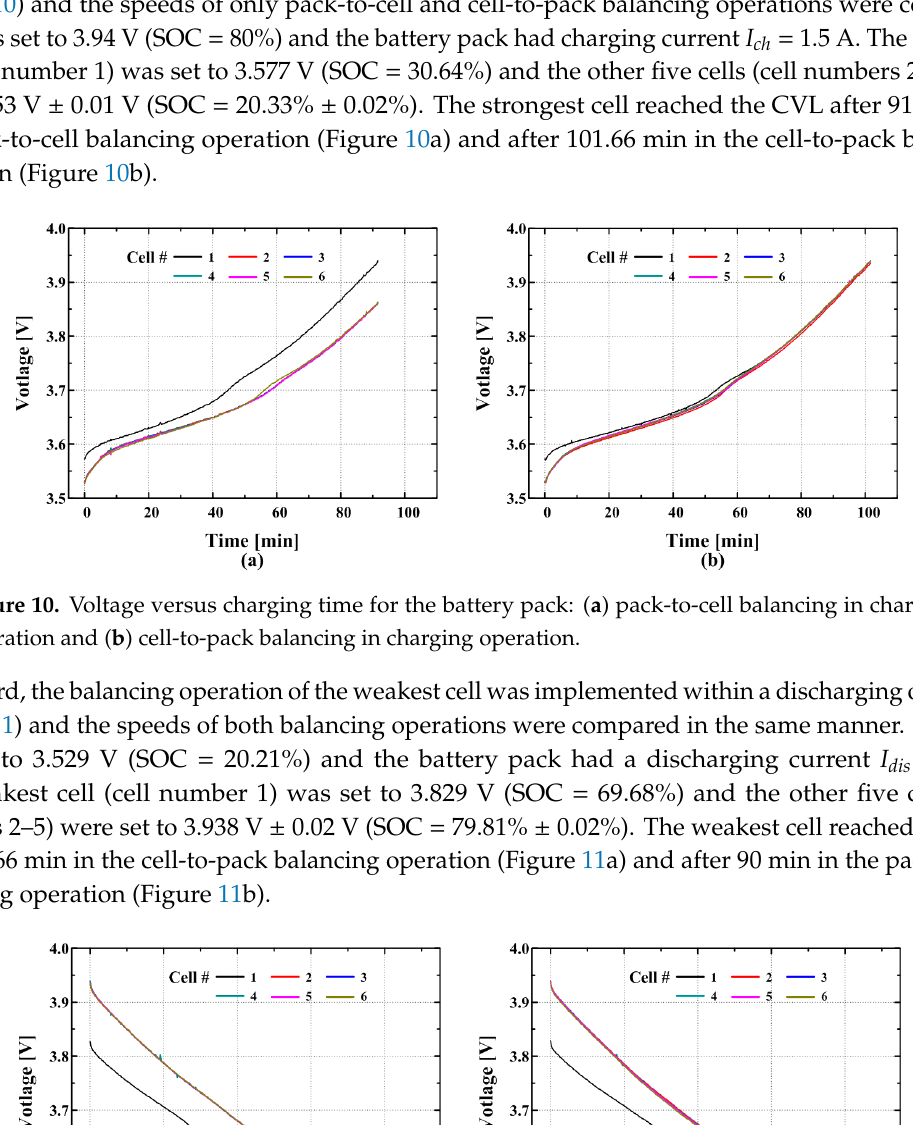
Figure 9. Voltage versus balancing time for the proposed charge equalization; six cells were connected in a static condition.